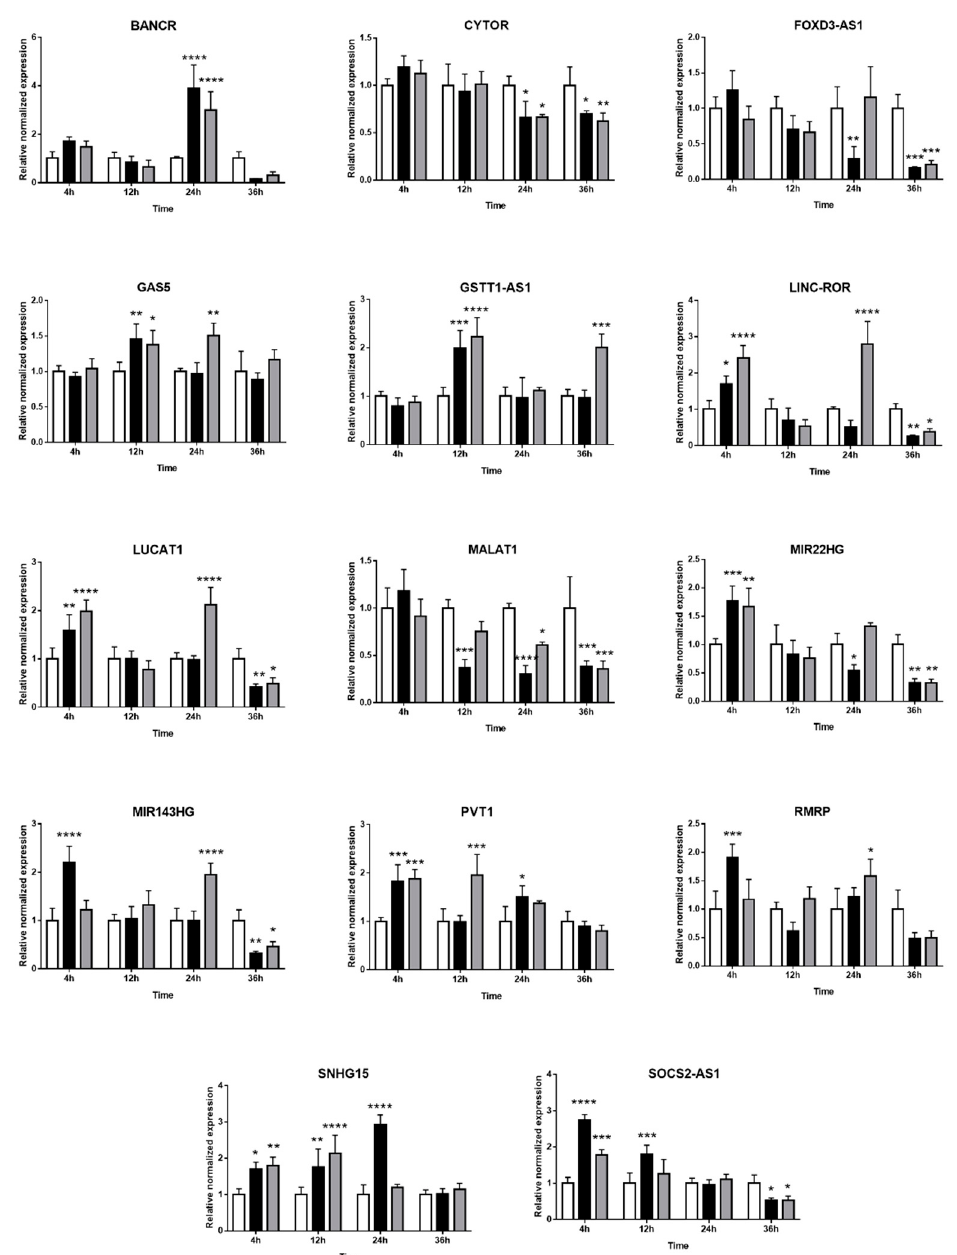
Figure 3. Expression of long non-coding RNAs in human retinal Müller cells infected with T. gondii tachyzoites with similarity in response to parasite strains. Graphs show normalized lncRNA expression in uninfected versus GT-1 and GPHT strain-infected MIO-M1 cells (multiplicity of infection = 5; evaluated time points post-infection = 4, 12, 24, and 36 h). Reference genes were ribosomal protein lateral stalk subunit P0 (RPLP0) and peptidylprolyl isomerase A (PPIA). Data were analyzed by two-way ANOVA with Bonferroni post-test. n = 3 cultures/condition. Bars represent mean normalized expression, and error bars indicate standard deviation. White columns represent uninfected, black columns represent GT1 strain-infected, and grey columns represent GPHT strain-infected. * p < 0.05, ** p < 0.01, *** p < 0.001, and **** p < 0.0001.